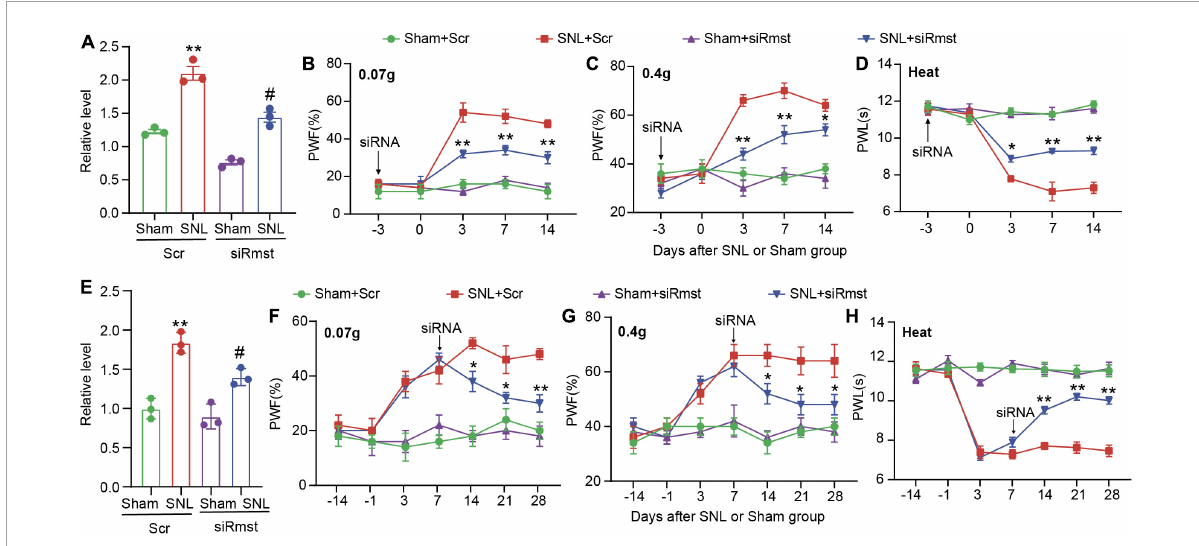
FIGURE3 Blocking nerve damage triggered rhabdomyosarcoma 2-associated transcript ( Rmst ) expression in DRG mitigated the nerve damaged-induced nociceptive hypersensitivity. (A) Level of Rmst in the L4 DRGs on day 14 after nerve injury model in presence of siRmst or Scr. n = 12 mice, One-way ANOVA followed by post-hoc Tukey test, ** P < 0.01 compared with Sham + Scr group and # P < 0.05 compared with SNL + Scr group. (B–D) The PWF to von Frey filament (B,C) and the PWL to thermal stimuli (D) on the development period of NP. n = 5 mice, two-way ANOVA followed by post-hoc Tukey test, * P < 0.05 and ** P < 0.01 compared with the SNL + Scr group. (E) Level of Rmst in the L4 DRGs on day 28 after nerve injury model in presence of siRmst or Scr. n = 12 mice, One-way ANOVA followed by post-hoc Tukey test, ** P < 0.01 compared with Sham + Scr group and # P < 0.05 compared with SNL + Scr group. (F–H) The PWF to von Frey filament (F,G) and the PWL to thermal stimuli (H) on the maintenance period of NP. n = 5 mice, two-way ANOVA followed by post-hoc Tukey test, * P < 0.05 and ** P < 0.01 compared with SNL + Scr group. Paw withdrawal frequency: PWF; Paw withdrawal latency: PWL.